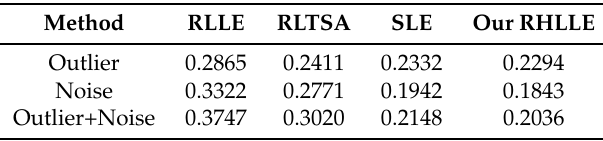
Table 2. The GSCD results of RLLE, RLTSA, SLE and our RHLLE on the ISOFACE image set with outliers, noise and both outliers and noise